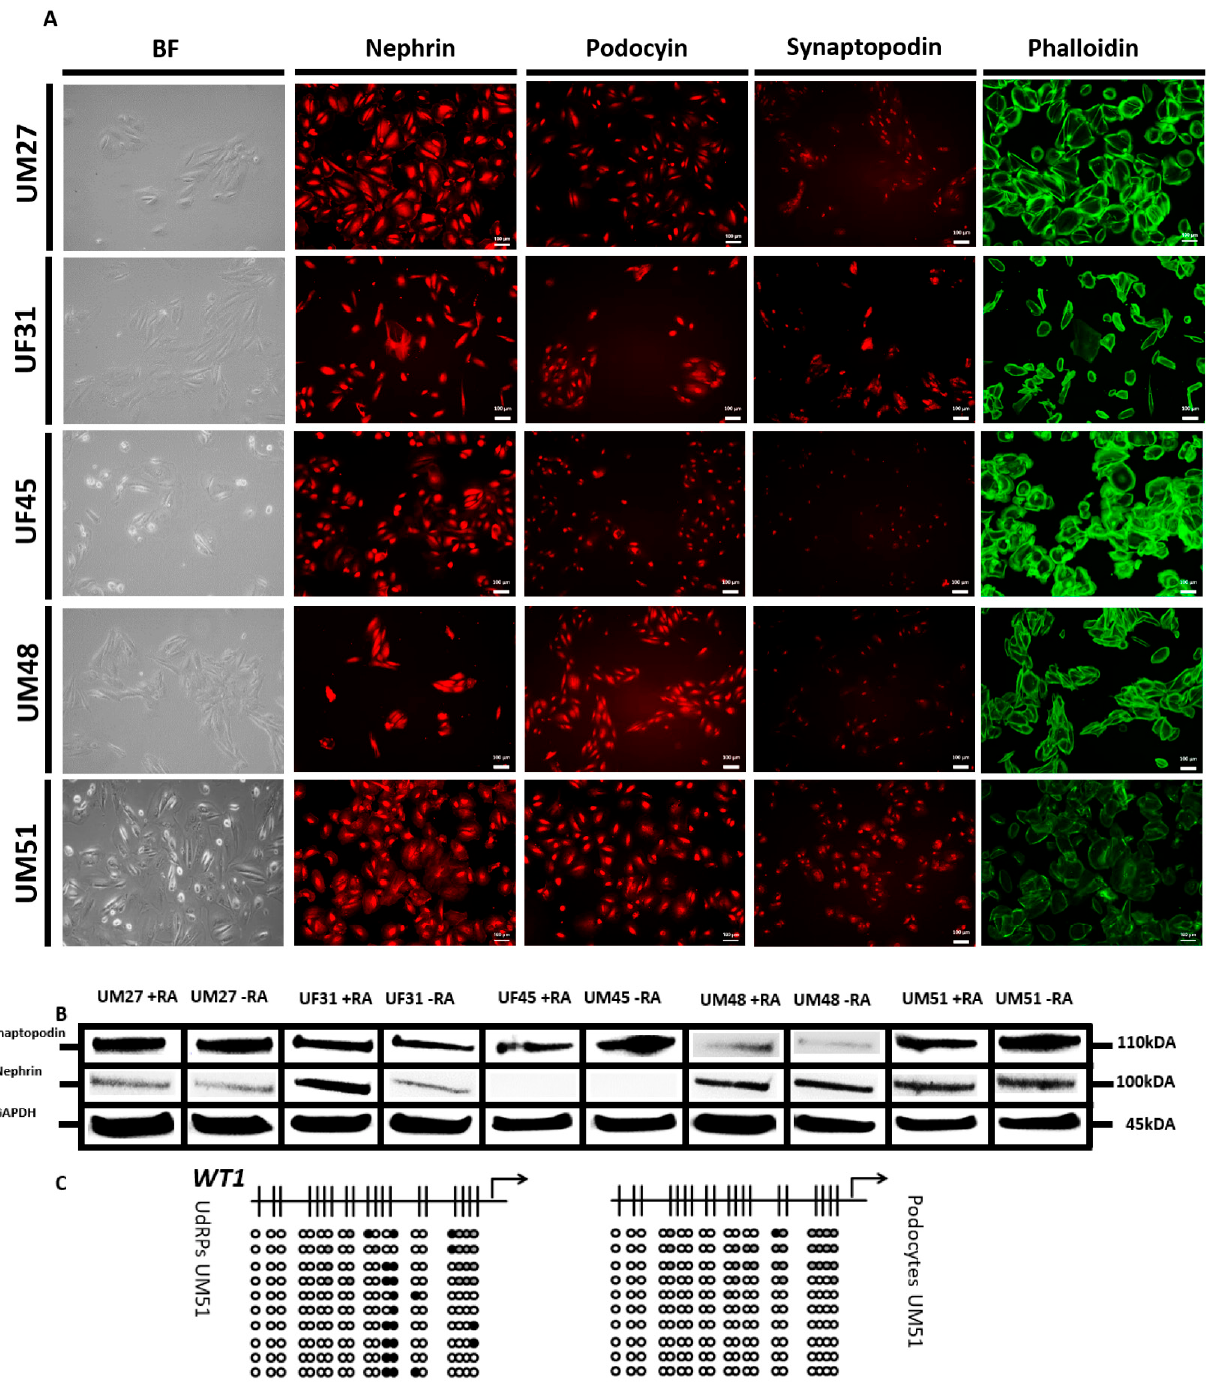
Figure 2. Retinoic acid enhances the maturation of UdRPC-derived podocytes. UdRPCs differenti- ated into podocytes by low density cultivation in advanced RPMI medium supplemented and with 30 µM retinoic acid. Immunofluorescence-based detection of nephrin, podocin, and synaptopodin expression. Podocyte cytoskeleton was stained with phalloidin ( A ). Expression of podocyte markers nephrin and synaptopodin was determined by Western blot-based detection ( B ). Bisulfite genomic sequencing of a 270 bp long WT1 promoter fragment, spanning 19 CpG-dinucleotides, provides detailed information about the dynamic DNA methylation changes occurring during the differenti- ation process into podocytes ( C ). Black, white, and grey circles refer to methylated, unmethylated, and undefined CpG dinucleotides, respectively. UdRPCs show dense methylation patterns at CpG position 12 and 13, whilst differentiated podocytes show a lack of